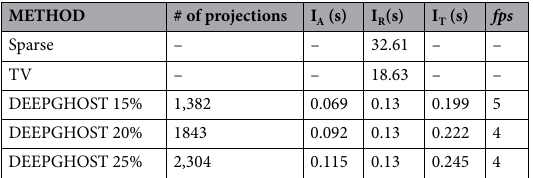
Table 1. Time breakdown for practical